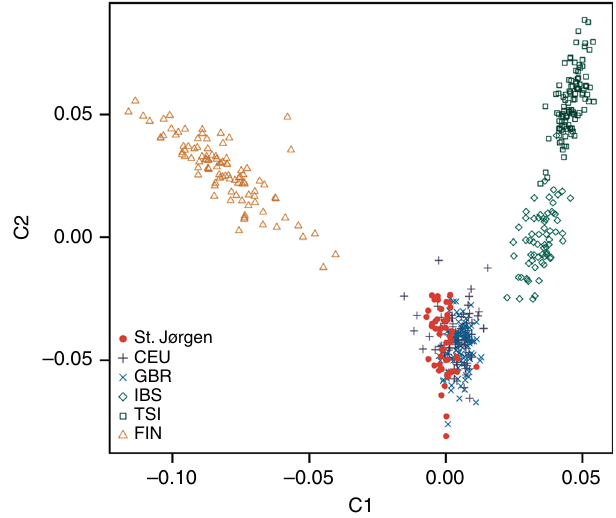
–0.10 Fig. 5 Relationship of 53 medieval leprosy-positive Danes to contemporary Europeans. Principal component analysis plot for 53 medieval St. Jørgen individuals in relation to European population samples from the 1000 Genomes project. (CEU, Northern Europeans from Utah; GBR, British in England and Scotland; IBS, Iberian population in Spain; TSI, Tuscans in